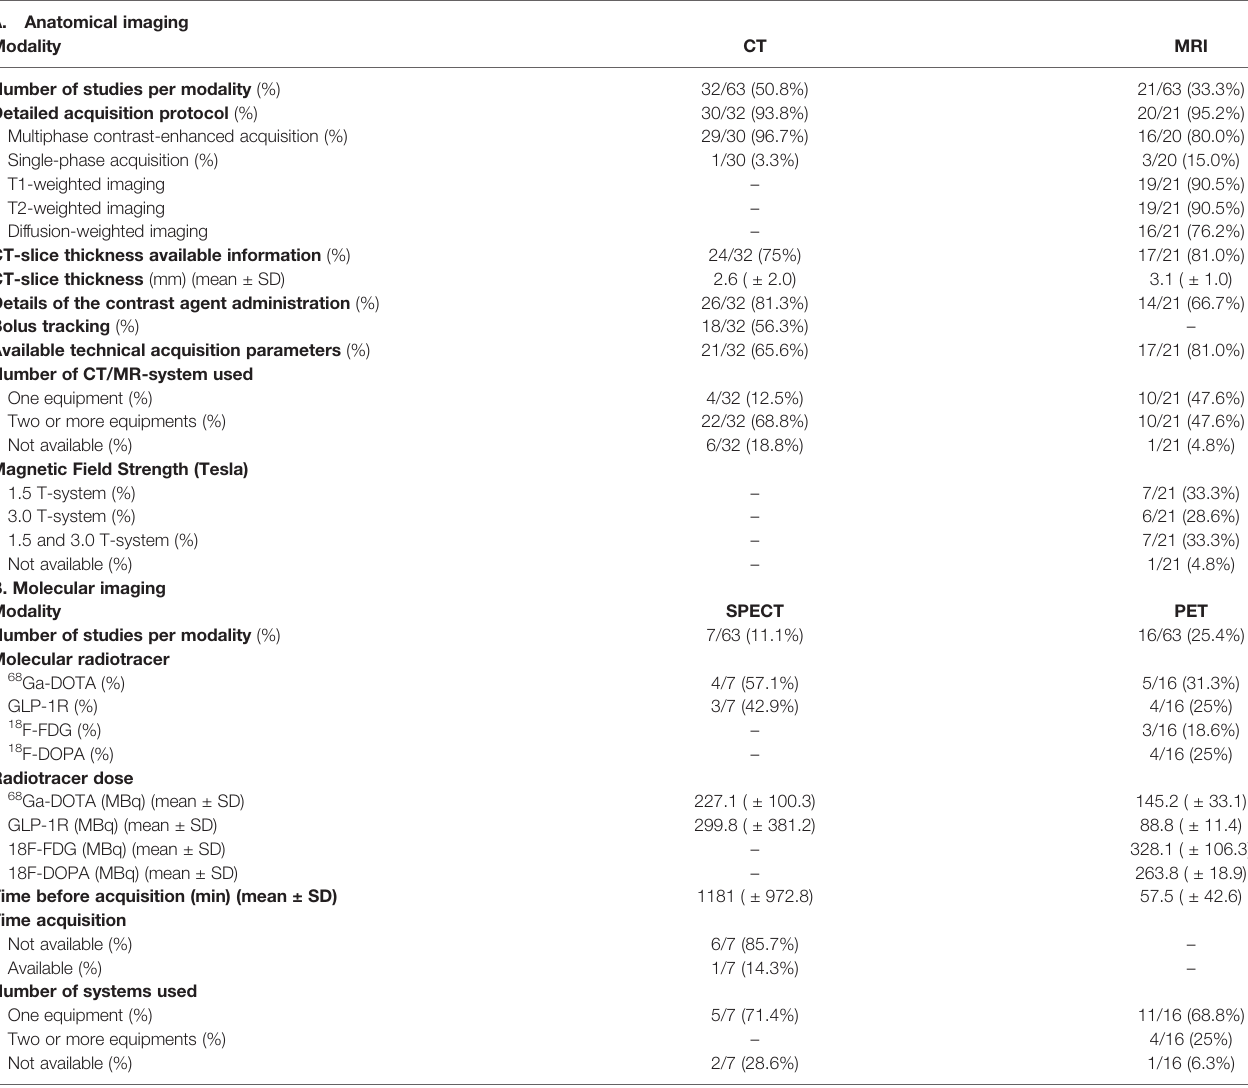
TABLE 4 | Imaging methods, examination protocols and technical details for each imaging